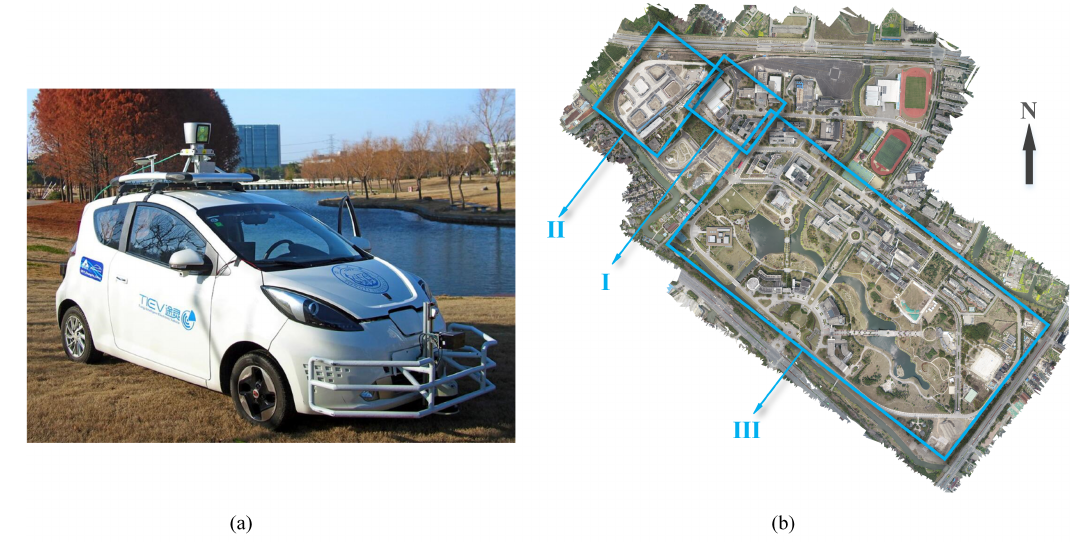
Figure 8. The TiEV autonomous driving platform and the selected areas for mapping. I: a loop road; II: the IV evaluation field; III: the